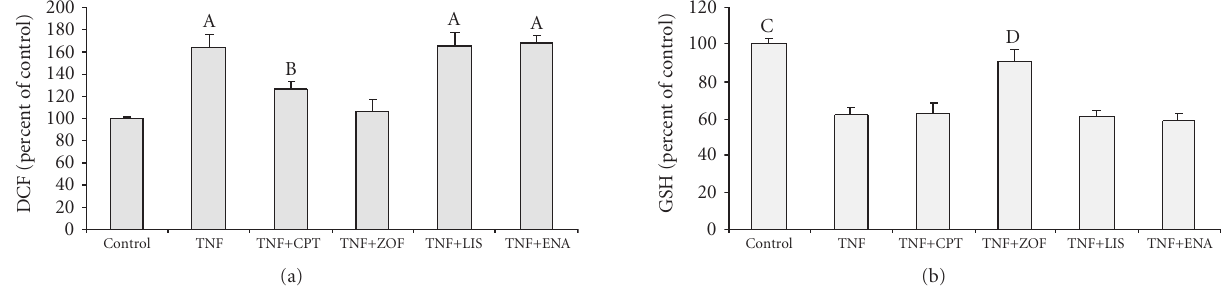
Figure 3: E ff ects of 10 − 8 M captopril (CPT), zofenoprilat (ZOF), lisinopril (LIS), and enalaprilat on TNF α -induced intracellular oxidative stress as evaluated by dichlorofluorescein (DCF, (a)) and glutathione (GSH, (b)) content. (A) P < . 01 or less versus control and TNF+ZOF and P < . 002 versus TNF+CPT; (B) P < . 0001 versus control and P < . 01 versus TNF+ZOF. (C) P < . 0001 versus TNF, TNF+CPT, TNF+LIS, and TNF+ENA and P < . 02 versus TNF+ZOF; (D) P < . 0004 or less versus TNF, TNF+CPT, TNF+LIS, and